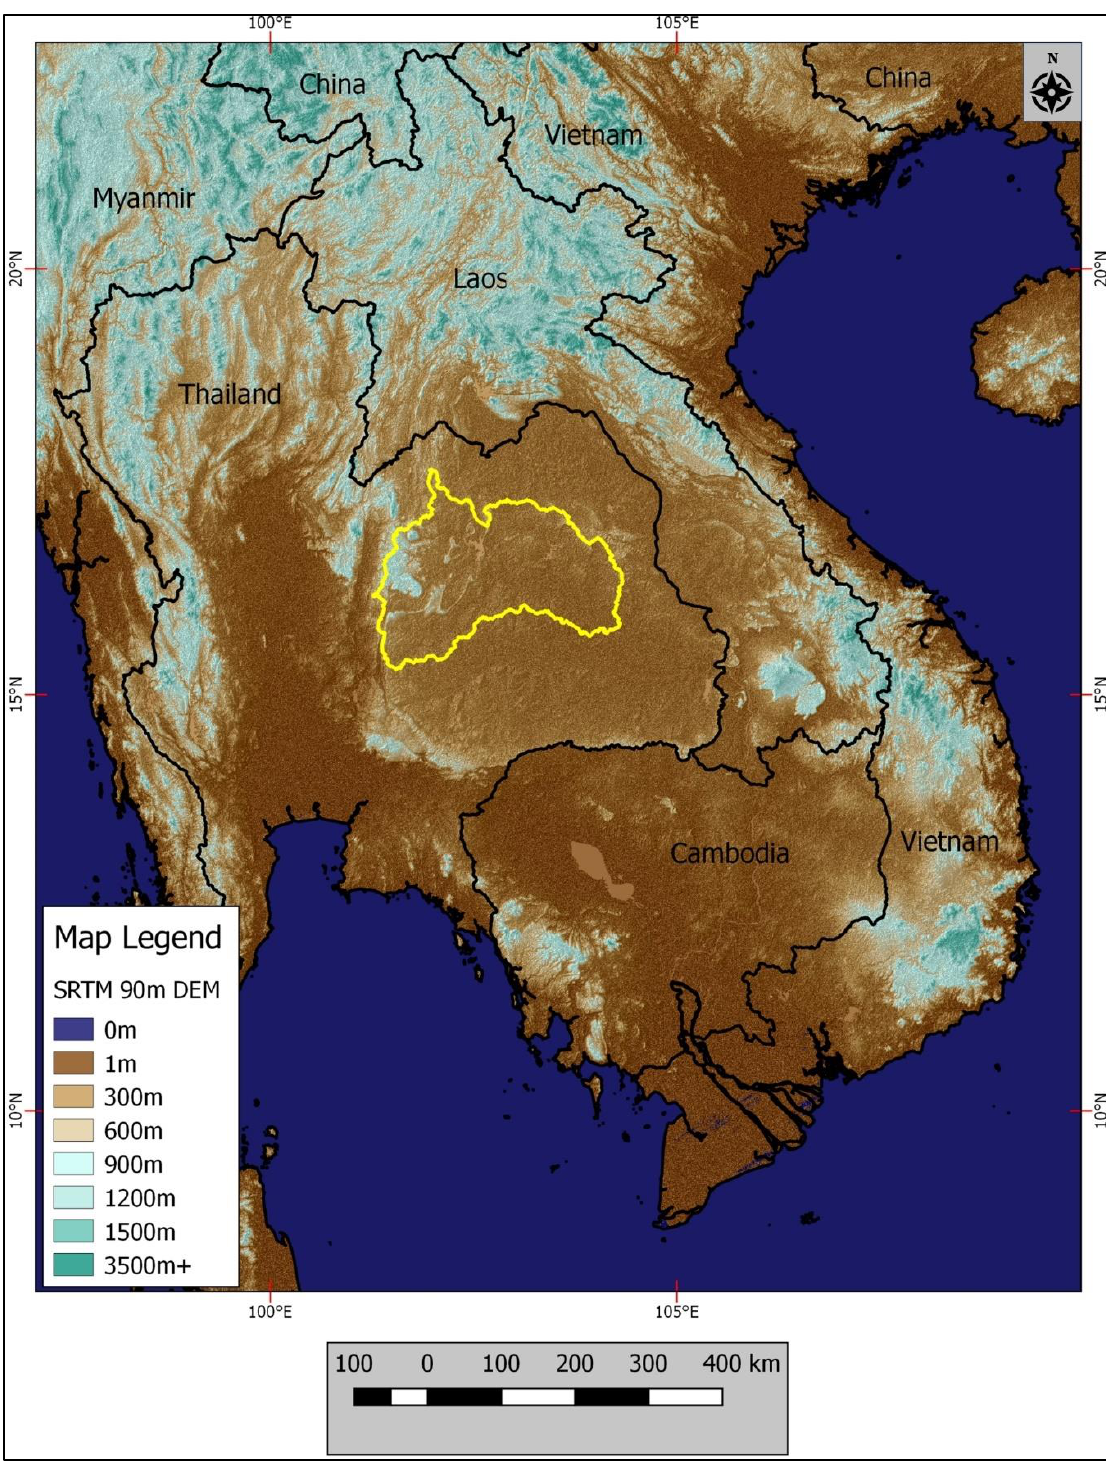
Figure 1 . Location of sub-basin 9 study area (in yellow) with respect to countries (in black) in the Lower Mekong Basin region of Southeast Asia. The underlying 90m elevation map is from NASA Shuttle Radar Topography Mission (SRTM) data.